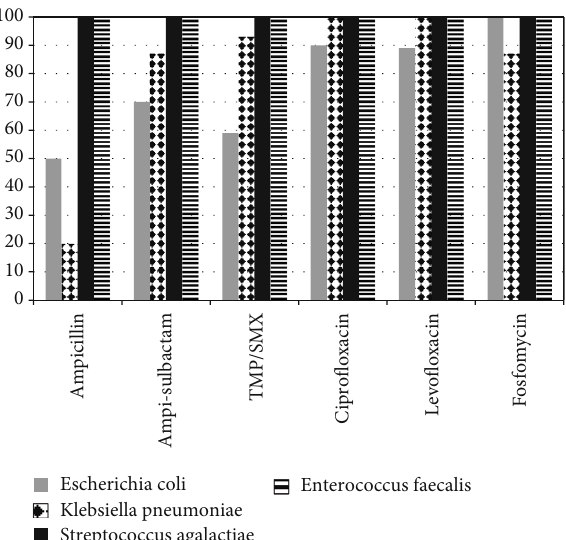
Figure 5: Susceptibility pattern of E.coli , K. pneumoniae ,